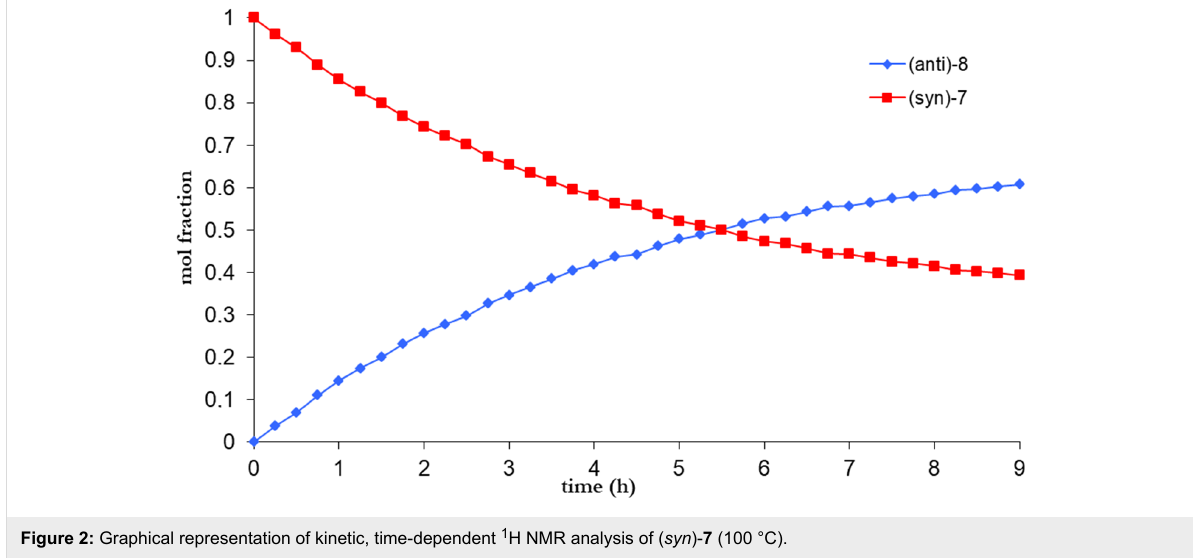
Figure 2: Graphical representation of kinetic, time-dependent 1 H NMR analysis of ( syn )- 7 (100 °C).